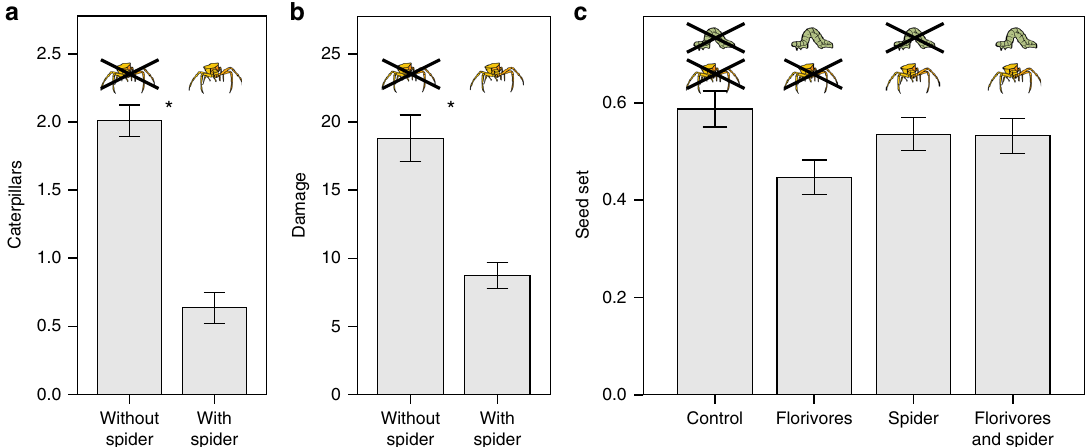
Fig. 3 Effect of crab spiders on damage in fl icted by fl orivory. a Number of remaining fl orivores on plants with and without crab spiders on the in fl orescence ( N = 50). Florivores were counted at the end of the day after three caterpillars have been placed on plants in the morning. Each bar represents a mean ± s.e., signi fi cant differences between treatments are indicated by an asterisk. b Florivore damage in plants with and without crab spiders ( N = 50). Damage was measured after Plutella xylostella feeding for 4 days; it was calculated as the sum of fl owers and buds with feeding damage by fl orivores. Each bar represents a mean ± s.e., signi fi cant differences between treatments are indicated by an asterisk. c Fitness (measured as seed set) of Biscutella laevigata plants under four treatments ( N = 100): control: no crab spider or fl orivores; fl orivores: infestation with fl orivores; spider: crab spider on the in fl orescence; fl orivores and spider: crab spider on the in fl orescence and infestation with fl orivores. Crab spiders and fl orivores had a signi fi cant interactive effect on plant fi tness; crab spiders reduced the negative effect of fl orivores (mixed effect model: estimate ± s.e. = 0.14 ± 0.06, t = 2.205, P = 0.027)